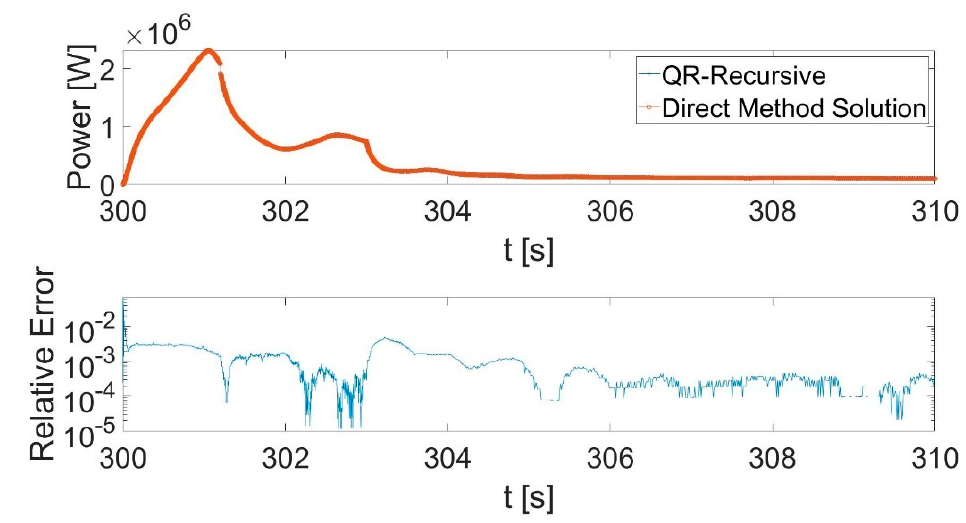
Figure 13. Testcase#1: ( Top ) the power dissipated during the transient in all passive structures. ( Bottom ) the relative error of the QR-recursive based method with respect to the Direct computation.